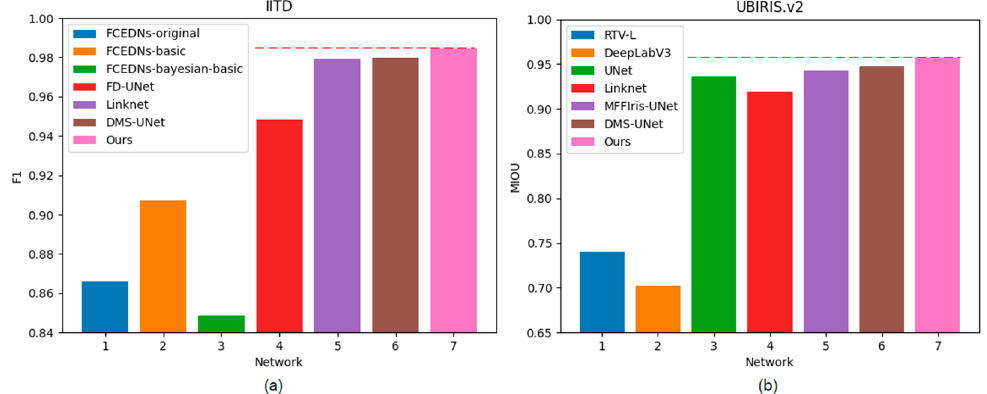
Figure 11. Histogram of F1 and MIOU on two databases: ( a ) IITD and ( b ) UBIRIS.V2.